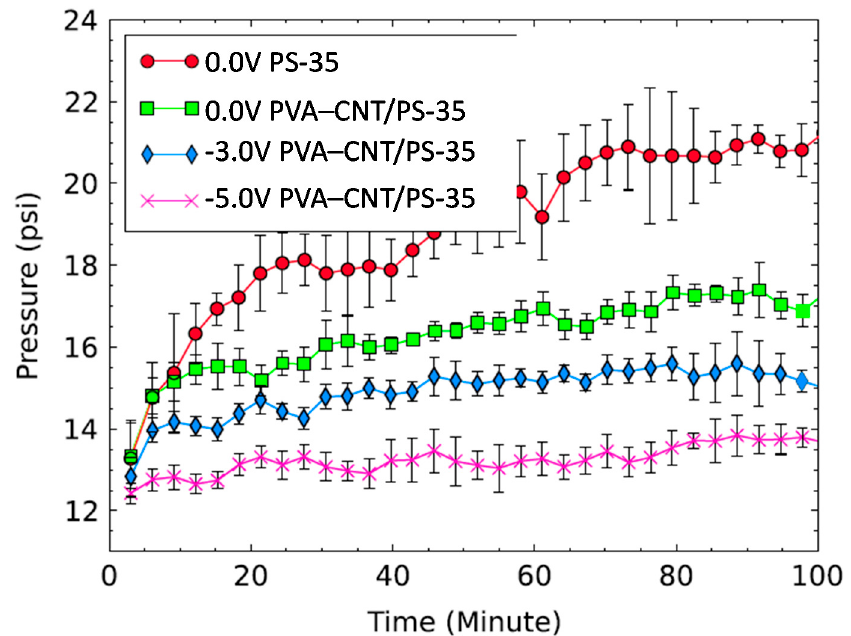
Figure 14. Effect of application of negative potentials to PVA/MWNT–COOH/PS-35 membranes on the extent of fouling caused by a solution consisting of 5 g·L − 1 alginic acid. Reduced levels of fouling led to smaller increases in applied pressure being required to maintain membrane operation. Reproduced with permission from Reference [122]. Copyright Elsevier,